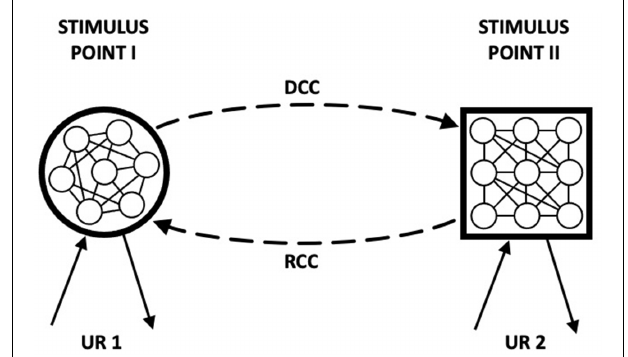
FIGURE 2 | “Figure 8 Scheme of the conditioned reflex with bidirectional connection. DCC, direct conditioned connection; RCC, reverse conditioned connection; UR 1, unconditioned reflex No. 1; UR 2, unconditioned reflex No. 2.” Adapted from Asratian (1965). Note that while Stimulus Points I and II are reciprocally connected, the elements within Stimulus Points I and II are neither fully interconnected with one another and nor is their nature made